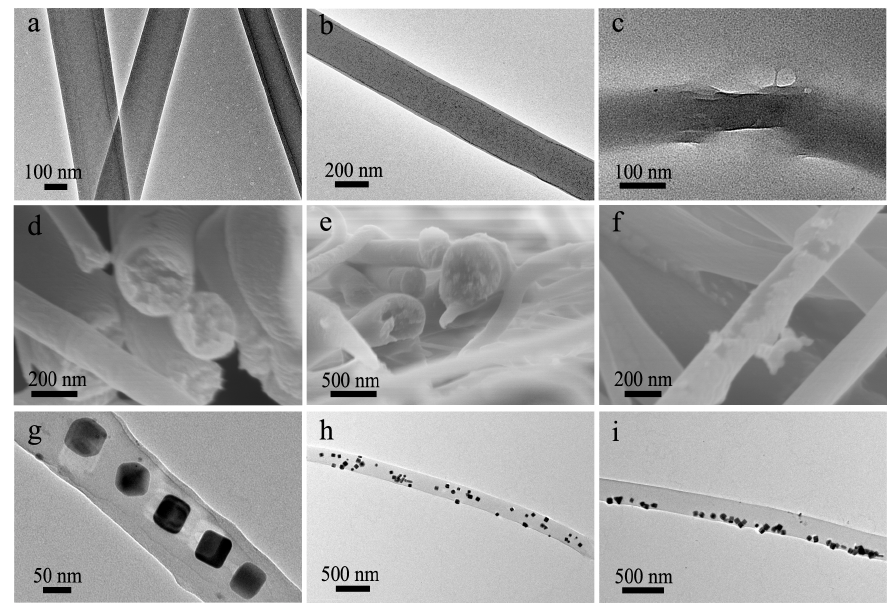
Figure 4. ( a – c ) TEM images of ( a , b ) intact co-electrospun nanofibers and ( c ) a co-electrospun nanofiber with broken shell; ( d – f ) SEM images of the ( d , e ) fracture surface and ( f ) surface of co-electrospun nanofibers; ( g – i ) TEM images of Ag-NPs loaded co-electrospun nanofibers, showing the distribution of Ag-NPs in the ( g ) central region, ( h ) whole nanofibers and ( i ) marginal area, respectively.